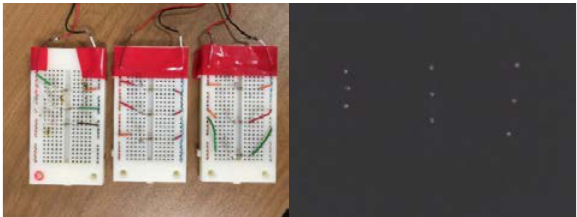
Figure 4: Variations in the view and axis caused by head move- ments.